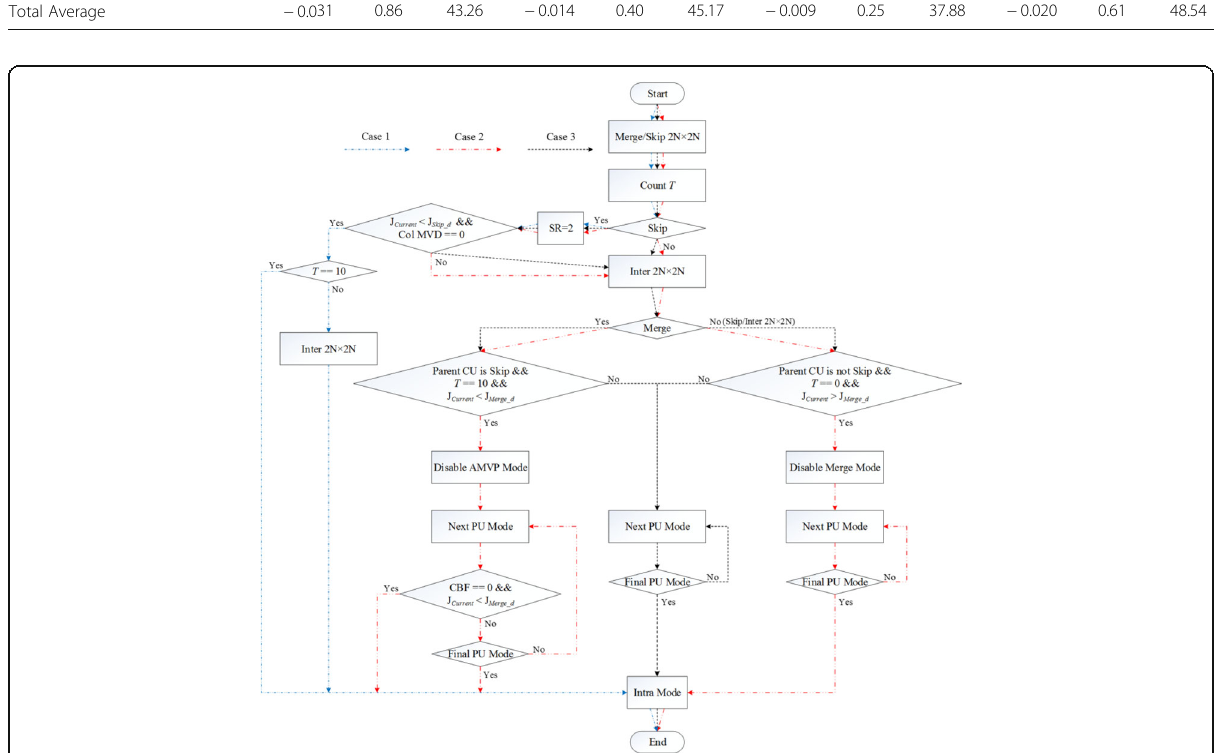
Fig. 22 Different cases for hit-rate